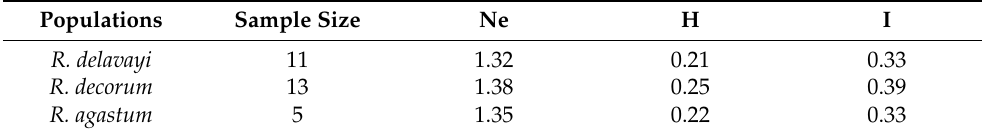
Table 2. Genetic variation information of three Rhododendron populations. Populations Sample Size Ne H